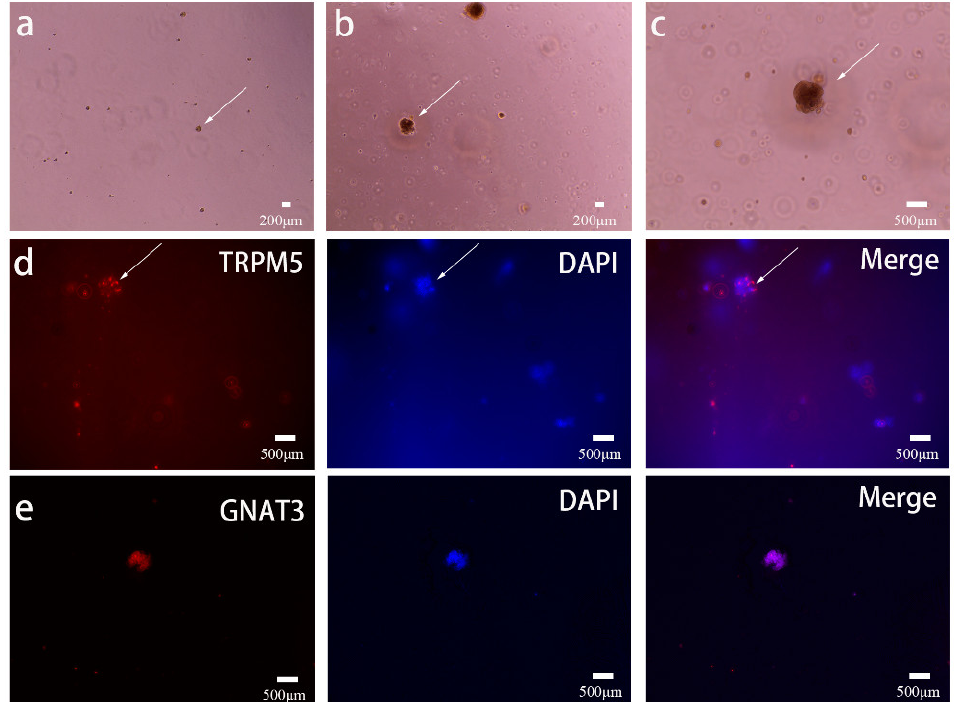
Figure 1. Light micrographs of ( a ) 7-day and ( b )14-day taste bud organoids prepared from neonatal mice. ( c ) A higher magnification image of ( b ). ( d ) Morphology and TRPM5 immunofluorescence staining of taste bud organoids cultured for 15 days using a TRPM5 rabbit polyclonal antibody ( left ) and DAPI fluorescent dye ( middle ). The right panel is a merged image of the left and middle. ( e ) GNAT3 immunofluorescence staining of taste bud organoids cultured for 15 days using GNAT3 Rabbit antibody ( left ) and DAPI fluorescent dye ( middle ). The right panel is a merged image of the left and middle.